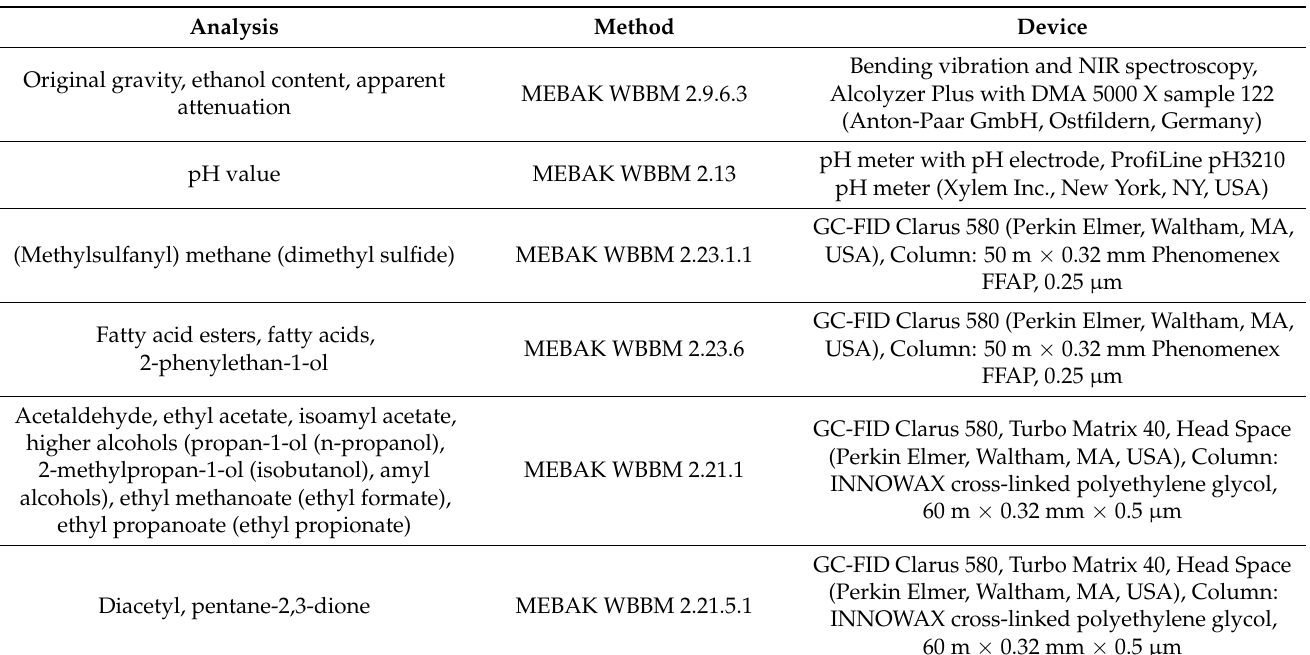
Table 2. Analytical standard methods of the wort and the beers according to MEBAK 1